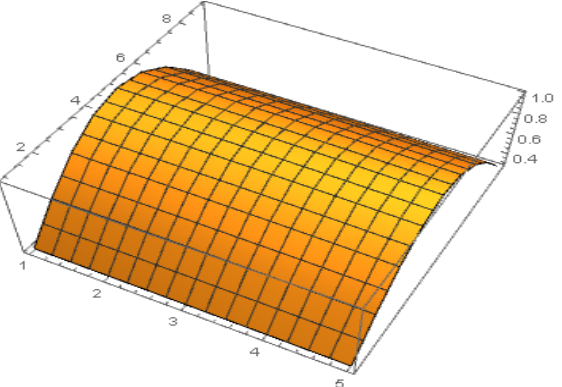
Figure 1. The lower exact solution of Equation (31) at 𝑡 = 0.01, 𝑥 = 0.1 , 𝑟 = 0 and 𝛽 = 1 .